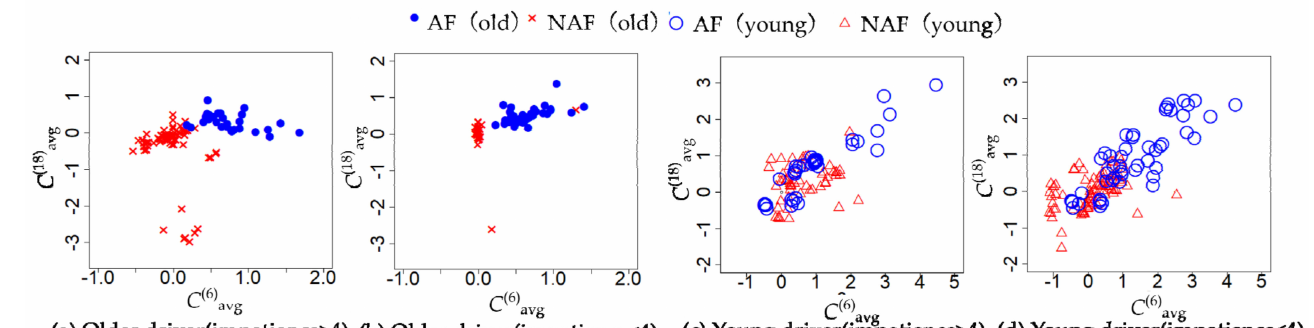
Figure 8. Near − infrared spectroscopy (NIRS) channels 6 and 18 when the driver feels impatient or